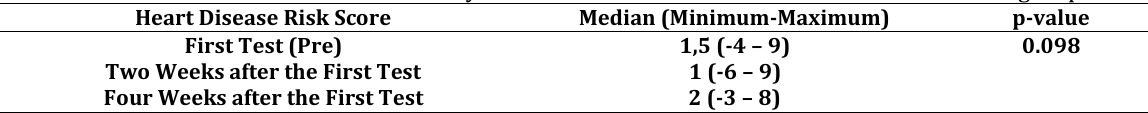
Table 9. The result of the Friedman test analysis score on the risk of heart disease in the control